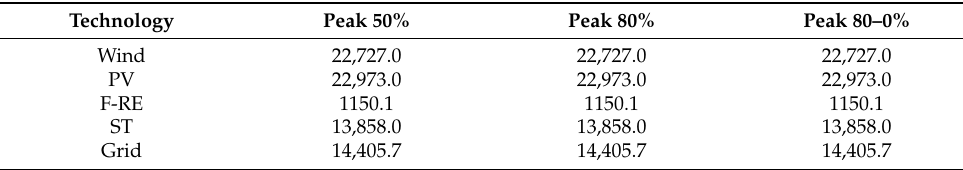
Table A15. Installed capacity in kW of peak scenarios.